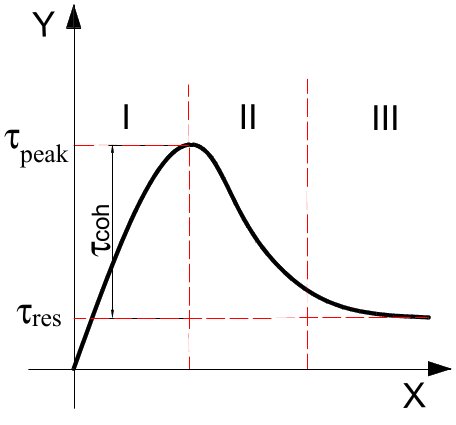
Figure 6. Stress-strain curves under different pressures.